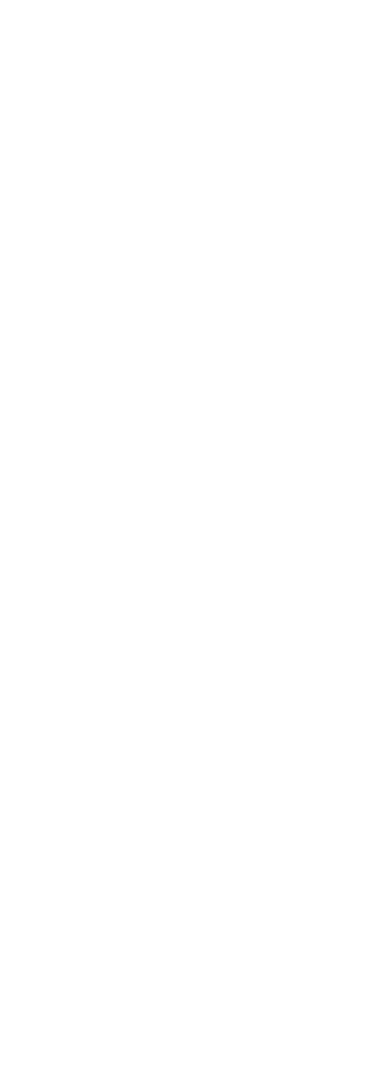
FIGURE 7 | Inactivated c-Src blocked EGFR-related survival pathways through sealing the phosphotyrosines of EGFR triggering cell deaths. (A) Immunoblotting analysis of Caspase-8, p-Src, c-Src, p-AKT, AKT, p-ERK, ERK, and b -actin in PC9, H1650, and H3255 cells treated with control and dasatinib for 48 h. (B) The immunocomplexes of EGFR-de fi cient A549 cells transfected the adenoviral HA-tagged tyrosine mutants of EGFR treated with EGF were eluted with antibody against EGFR, and whole elution was used to measure c-Src. (C) Schematic representation of various mutants of c-Src used in this study. (D – F) The immunocomplexes of PC9, H1650, and H3255 cells transfected lentiviral Casp8 shRNA were eluted with antibody against EGFR, and whole elutions were used to measure HA. (G) Microarray analysis of SH2 domains of intracellular proteins binding to EGFR in A549 cells attached on fi bronectin for 24 h. (H) Immunohistochemistry for p-Src expression in patients with EGFR-mutant lung adenocarcinoma representing CR, PR, and PD to TKIs by speci fi c antibody (×400). The relationship between p-Src IHC score and chemotherapy response was showed. * vs. intergroup, p < 0.05. (I) PC9, H1650, and H3255 cells were treated with ge fi tinib or ge fi tinib+dasatinib for 48 h. Cell viability was determined by measuring ATP levels using Cell Titer-Glo kit. Data were represented as mean ± standard deviation of duplicates. * vs. Ge fi tinib, p < 0.05. (J) PC9, H1650, and H3255 cells were treated with ge fi tinib or ge fi tinib+dasatinib for 48 h. Cells were analyzed for Annexin V/PI staining by fl ow cytometry. All experiments were repeated 3 times with similar results. **, vs. Ge fi tinib, p < 0.01. (K) Immunoblotting analysis of Caspase-8, p-Casp8, cleaved Casp8, and b - actin in PC9, H1650 and H3255 cells attached on fi bronectin for 24h treated with ge fi tinib+control (Control) and ge fi tinib+dasatinib (Dasa). Cells were labelled with [ 32 P]-orthophosphate. Phosphorylated RIPK1, RIPK3 and MLKL were measured by Cyclone Plus Phosphor Imager. (L) Subcutaneous xenograft assay of PC9, H1650, and H3255 cells transfected with adenoviral control shRNA and Casp8 shRNA in nude mice treated with control or dasatinib. Volumes of tumors were shown ( n = 10 per group). ** p < 0.01. * p < 0.05. (M) Subcutaneous xenograft assay of PC9, H1650 and H3255 cells in nude mice treated with control or ge fi tinib or ge fi tinib+dasatinib. Volumes of tumors were shown ( n = 10 per group). **, p < 0.01. *, p < 0.05. (N – P) Representative patient-derived tumor xenografts in nude mice treated with control or ge fi tinib or ge fi tinib+dasatinib. Volumes of tumors were shown ( n = 10 per group). ** p < 0.01. * p < 0.05. (Q) Response to ge fi tinib or ge fi tinib +dasatinib of patients with metastatic EGFR-mutant lung adenocarcinoma. ** p < 0.01. (R, S) Kaplan-Meier analysis of duration of response and overall survival in the cohort of PDX models, p <